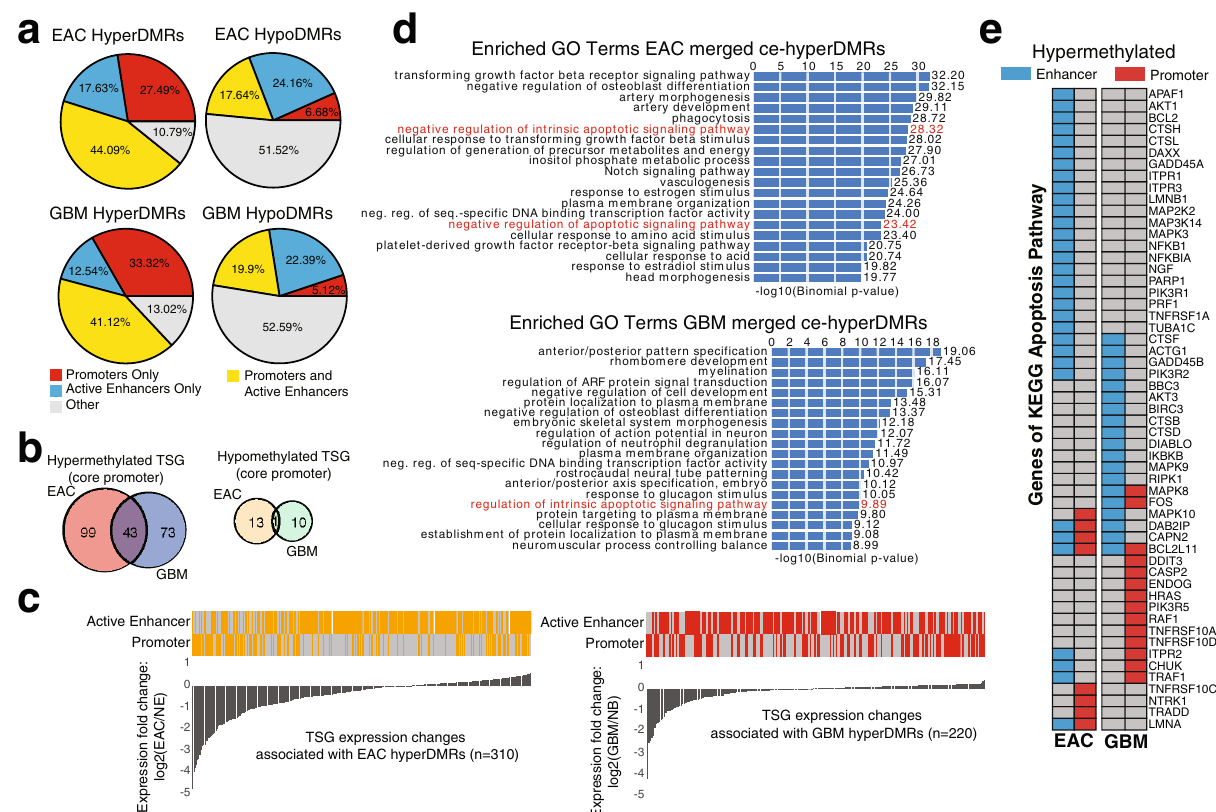
Fig. 2 EAC and GBM DMRs show similar characteristics on a pathway level. a Percentage of DMRs with active regulatory annotations (promoter and/or active enhancer) in EAC and GBM. b Overlap of tumor suppressor genes (TSGs) with abnormally methylated core promoters (1 kb, centered around TSS) in EAC and GBM. Left: hyperDMRs (overlap is signi fi cant: p < 8.39E − 14, hypergeometric test); right: hypoDMRs. c TSGs with abnormally methylated promoters (1 kb, centered around the TSS) and/or active enhancers in EAC (left) and GBM (right), accompanied by fold change in expression of TSGs in EAC and GBM. NB: normal brain; NE: normal endometrium. Orange and red bars indicate the presence of a DMR within an active enhancer/promoter in EAC and GBM hyperDMRs, respectively. d Top enriched GO terms (Biological Process) of ce-hyperDMRs in EAC (top) and GBM (bottom). Values represent the − log10(Binomial p -value). e Hypermethylation status of apoptosis gene promoters (red) and enhancers (blue) in EAC (left) and GBM